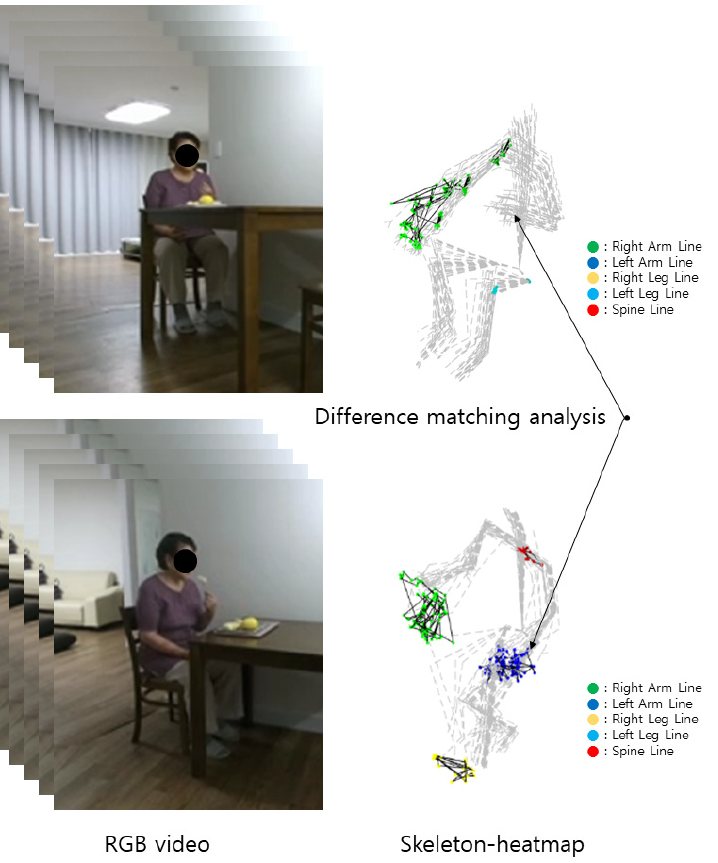
Figure 5. Difference analysis of skeleton-heatmaps for the behavior of an elderly person eating food with a fork.